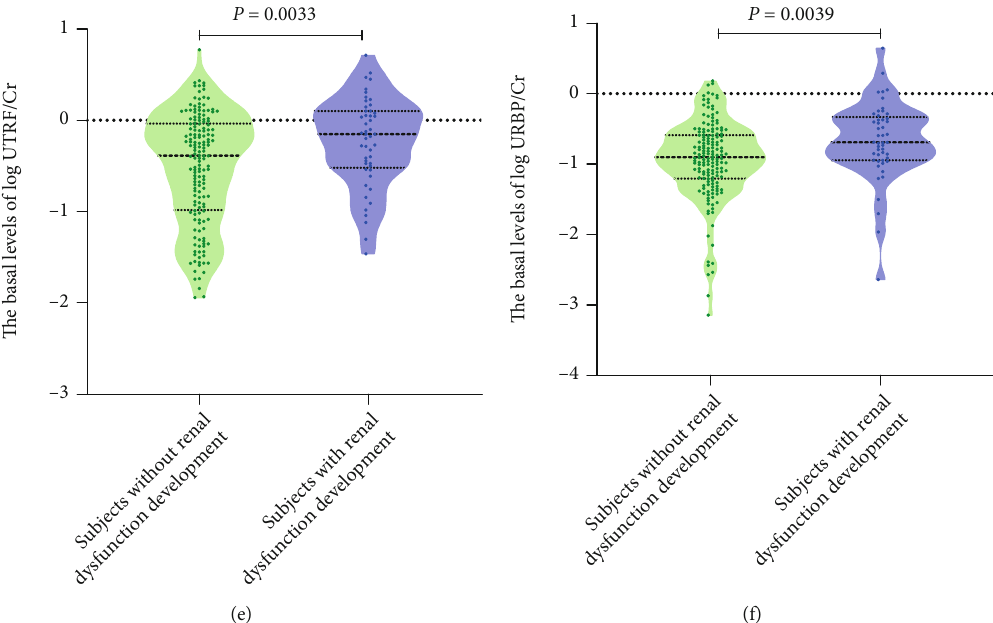
Figure 2: The violin plots of six markers at baseline, strati fi ed by the development of renal dysfunction. ACR: albumin-to-creatinine ratio; A1MCR: alpha-1-microglobulin-to-creatinine ratio; eGFR: estimated glomerular fi ltration rate; NGAL/Cr: neutrophil gelatinase-associated lipocalin-to-creatinine ratio; UTRF/Cr: transferrin-to-creatinine ratio; URBP/Cr: retinol-binding protein-to-creatinine